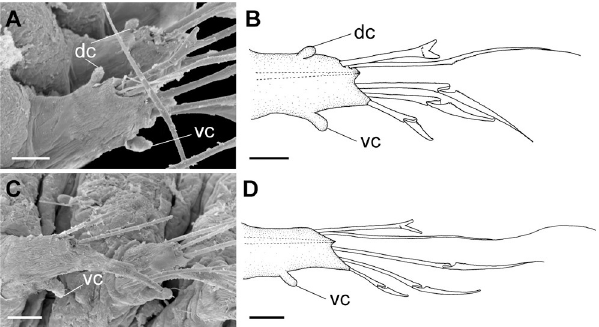
Fig 4. Meiodorvillea minuta (Hartman, 1965), ZUEC-POL. (A,B) parapodia from anterior region; (C,D) parapodia from posterior region; all anterior view. Abbreviations: dc = dorsal cirrus; vc = ventral cirrus. Scales: (A,B) = 10 μ m; (C, D) = 15.6 μ m.